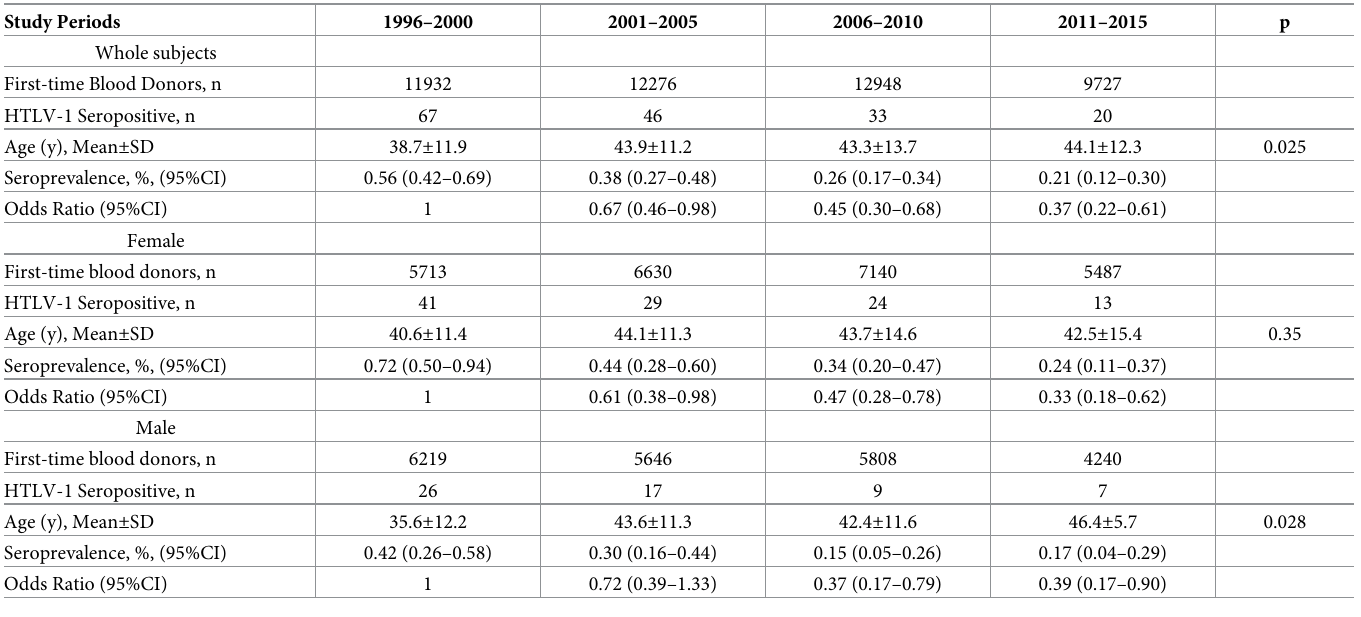
Table 4. Prevalence of HTLV-1 infection among first-time blood donors by genders in the four 5-year study periods. Study